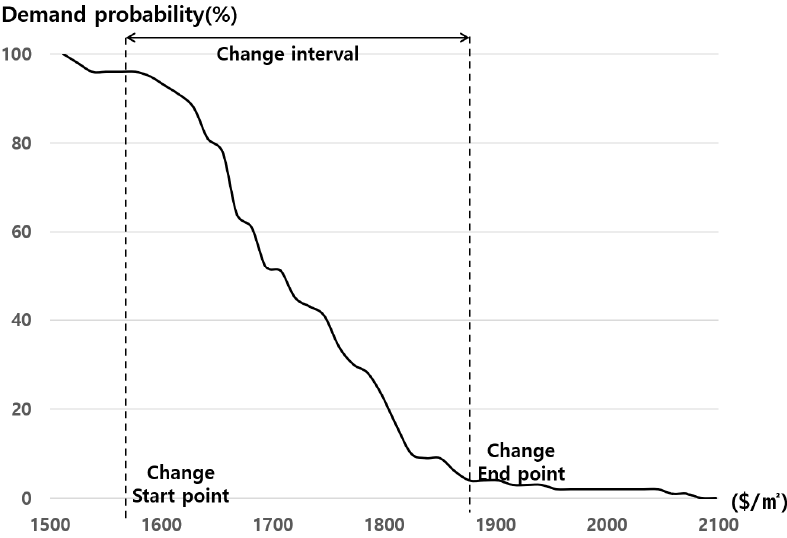
Figure 4. Apartment demand graph using UTP (Unique Target Point).